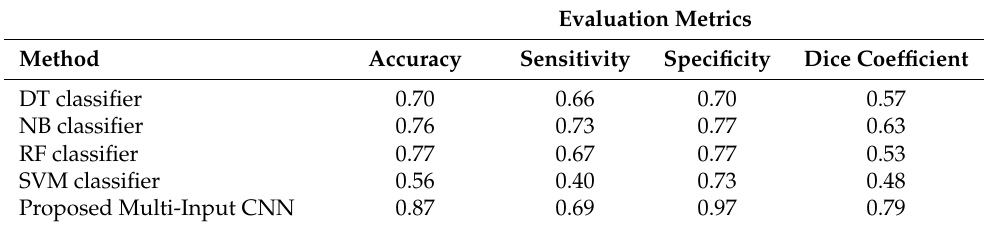
Table 3. Comparative performance for the proposed multi-input CNN system and machine learning methods that use hand-crafted features. “DT”—Decision Tree. “RF”—Random Forest; “NB”—Naive Bayes; “SVM”—Support Vector